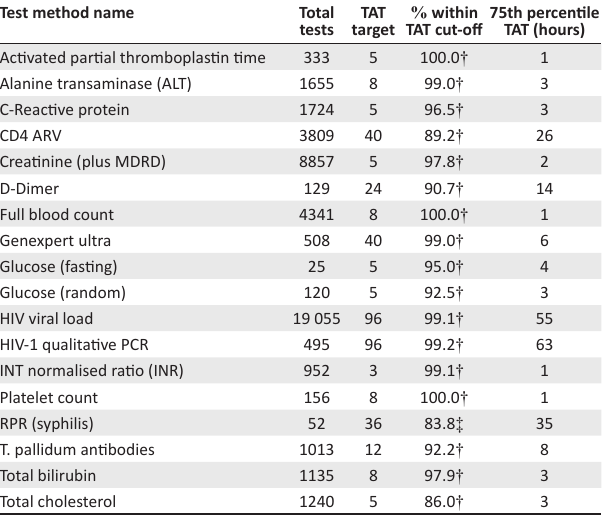
TABLE 1: Sample of a turn-around time dashboard table that lists the outcomes for the basket of tests, South Africa, 2018. Test method